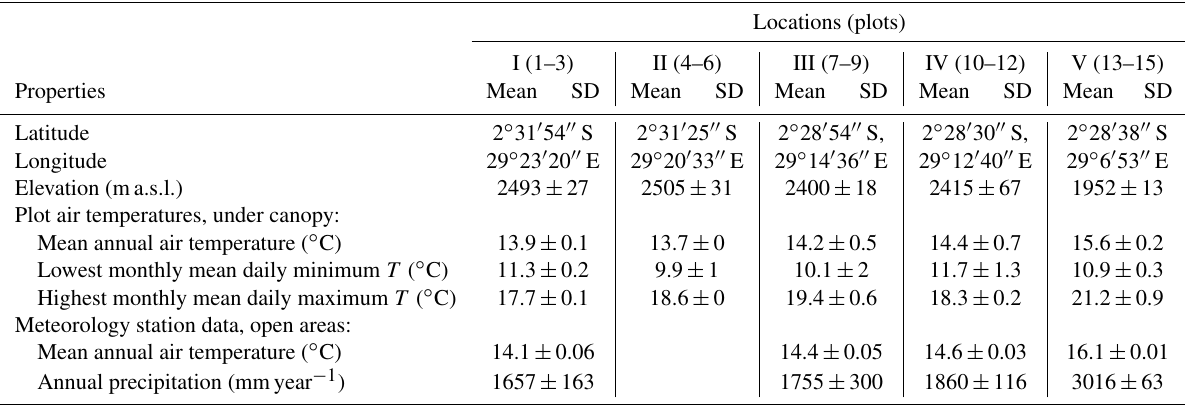
Table 1. Temperature ( T ) and precipitation at five locations along a 32km transect with 15 plots in Nyungwe tropical montane forest during July 2013 to June 2015. Temperature at 3m above ground was measured both below the canopy in each plot and at four meteorology stations in open areas. SD of plot and meteorology station data represents variation among plots and months, respectively. Plot numbers at each location are given in